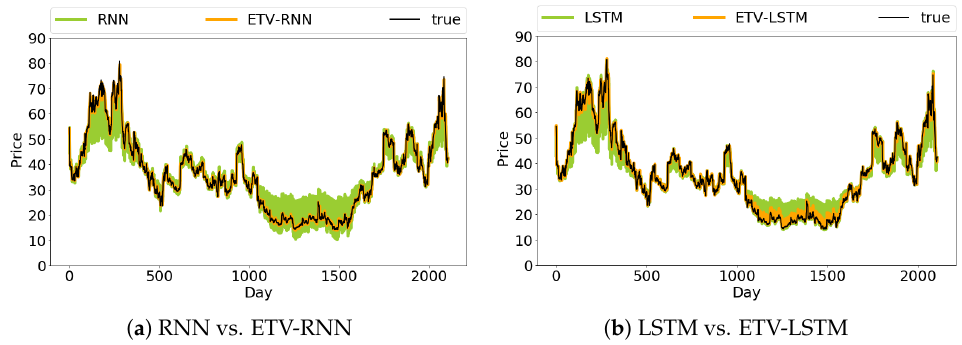
Figure 7. Many-to-many stock price prediction from methods RNN, ETV-RNN, LSTM, and